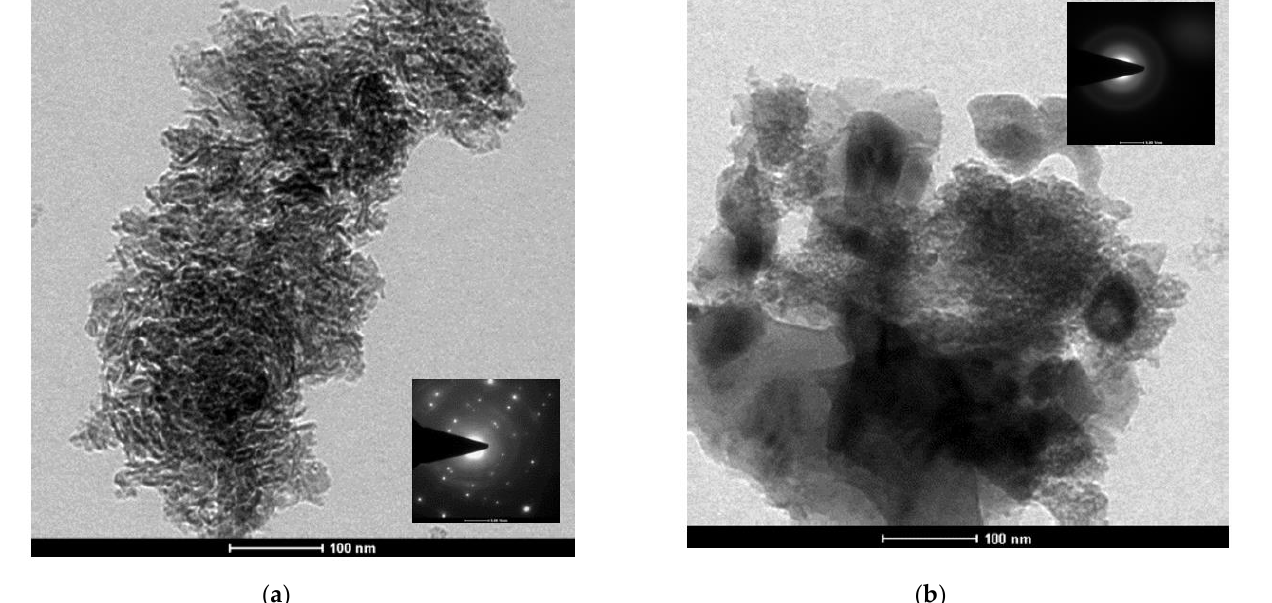
Figure 10. TEM images of the ( a ) RMP1-500 and ( b ) RMP2-500 samples.